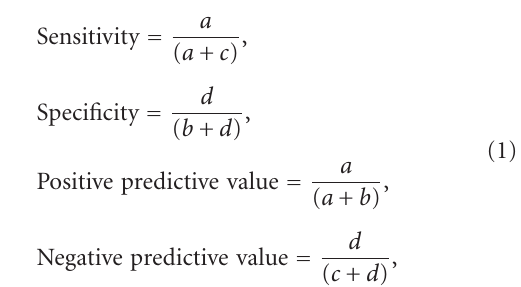
Figure 3: Spearman’s correlation analysis between ENA6 Sm and